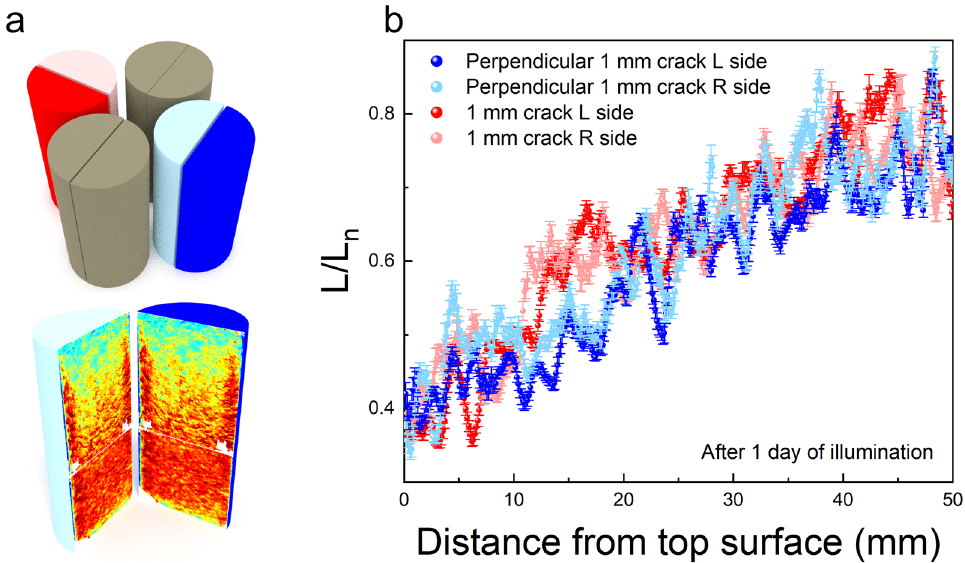
Figure 2. Effect of crack orientation. ( a ) Schematic representation of the two cores with 1 mm crack widths (blue and red) positioned perpendicularly to each other. ( b ) Crack surface bleaching profiles of both halves of the two perpendicular